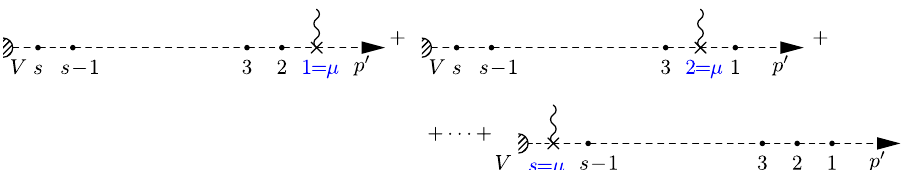
vertex.Theshadedvertexontheextremeleftisthevertex V .Analogous diagrams for fermions do not